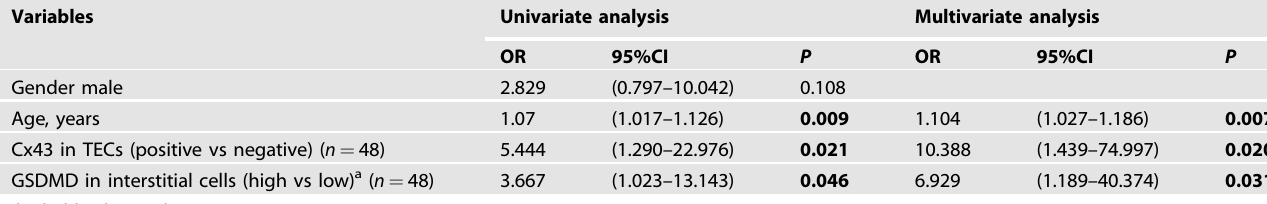
Table 2. Risk factors associated with eGFR <90 ml/min/1.73 m 2 during follow-up periods.